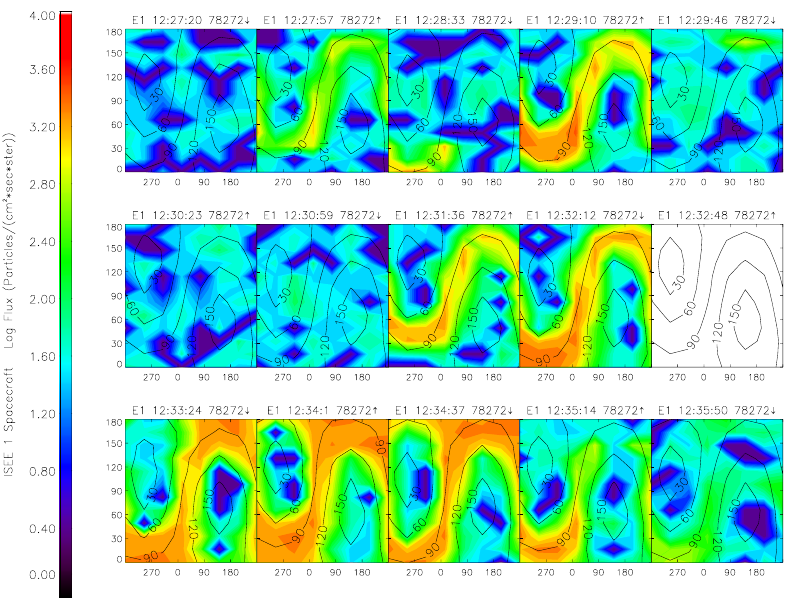
Fig. 4. ISEE-1 MEPE 3-D pitch angle distributions of electron flux (22.5–39.0keV) as the spacecraft enters the CDC. The figure spans the time period 12:27:20–12:35:50 UT. As the spacecraft enters the CDC, the flux shows a clear peak at a PA of 90 ◦ . Zone 1, as defined in Sect. 2.1, is shown in the third and fourth panels from the left on the top row. Zone 2 begins in the middle panel on the second row and continues into Fig. 5.